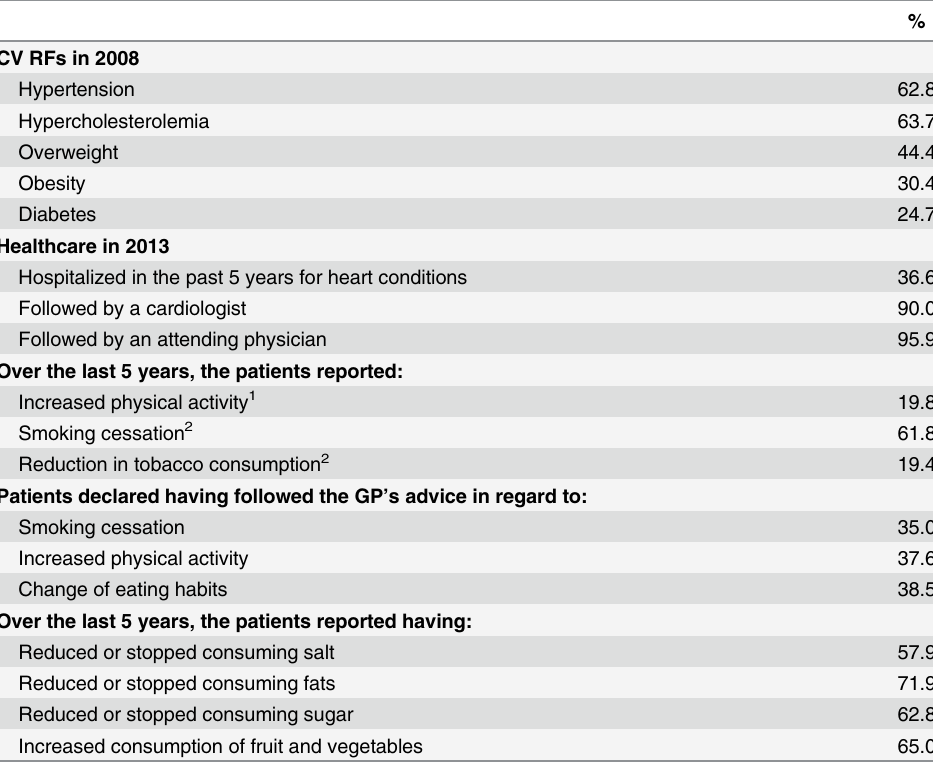
Table 2. CV Risk Factors in 2008, healthcare in 2013 and preventive behaviours between 2008 and 2013.